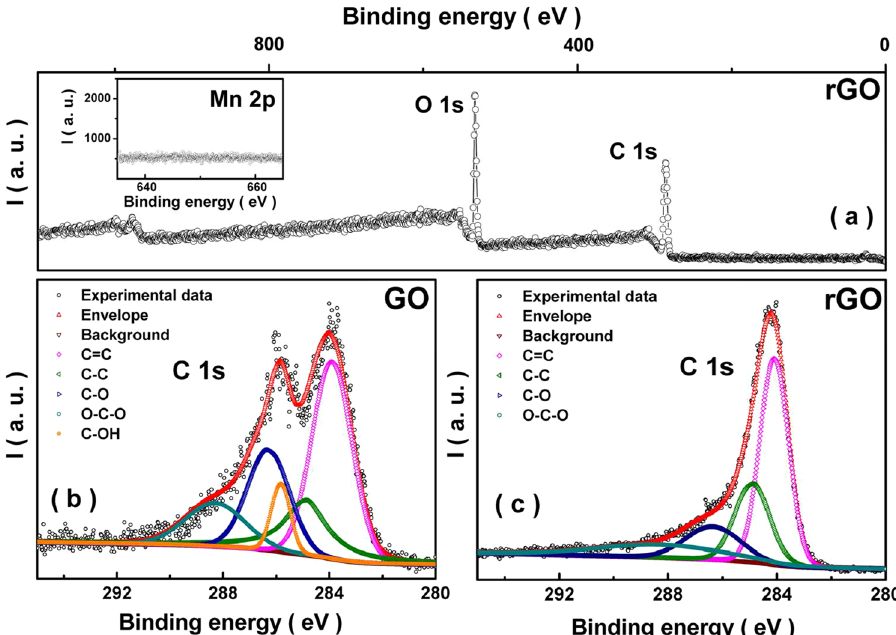
Figure 6. ( a ) Intensity (I) versus binding energy (B. E.) in the full scan range for the XPS of the rGO film obtained after a 2 hour exposure to a 4 Watt, 365 nm UV lamp. ( b ) A multiple peak deconvolution of the GO C1s XPS data (corresponding to –C–C–, –C = C–, –C–O, –O–C–O–, –OH and –C = O respectively). The inset in panel (a) shows the XPS data corresponding to Mn 2p binding energy region for the rGO sample. ( c ) rGO C1s XPS data for the sample along with the deconvoluted peak structure corresponding to –C–C–, –C = C–, –C–O, –O–C–O–, and –C = O are